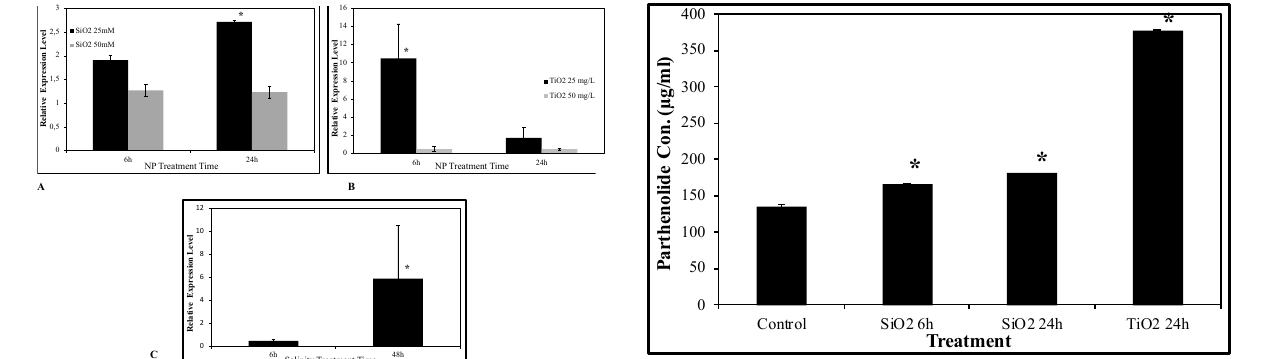
Fig. 6. The effect of elicitors on expression of TpCarS gene in fever- few. A: SiO 2 NP treatment; B: TiO 2 NP treatment; C: Salinity stress.